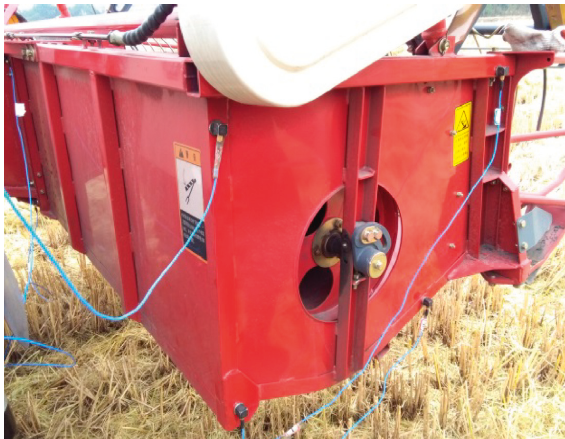
Figure 12: Front header physical